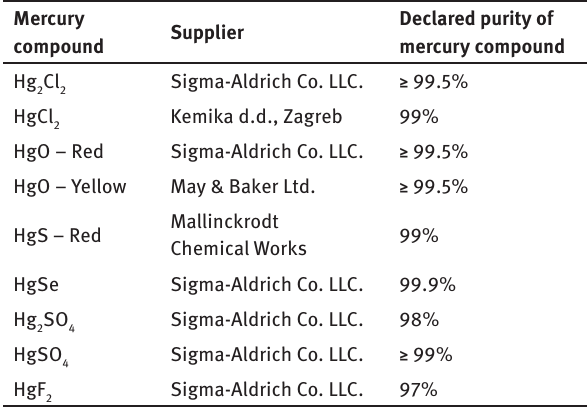
Table 2. Type of mercury compound, suppliers and